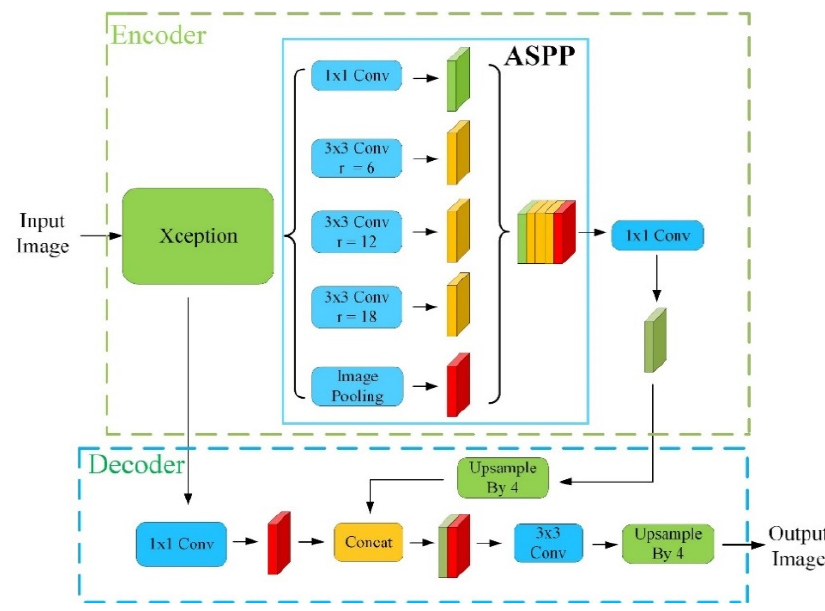
Figure 4. DeepLabv3+ network architecture.